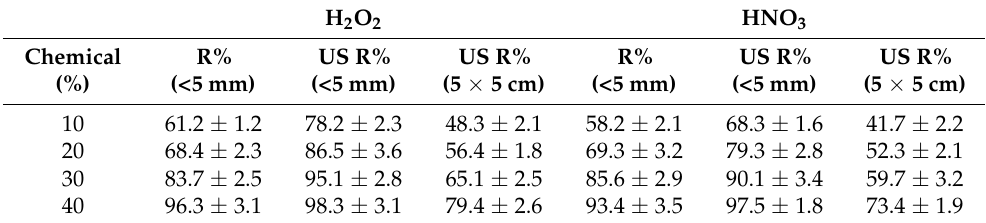
Table 2. Effect of the oxidant concentration on the detachment efficiency (n = 3) .